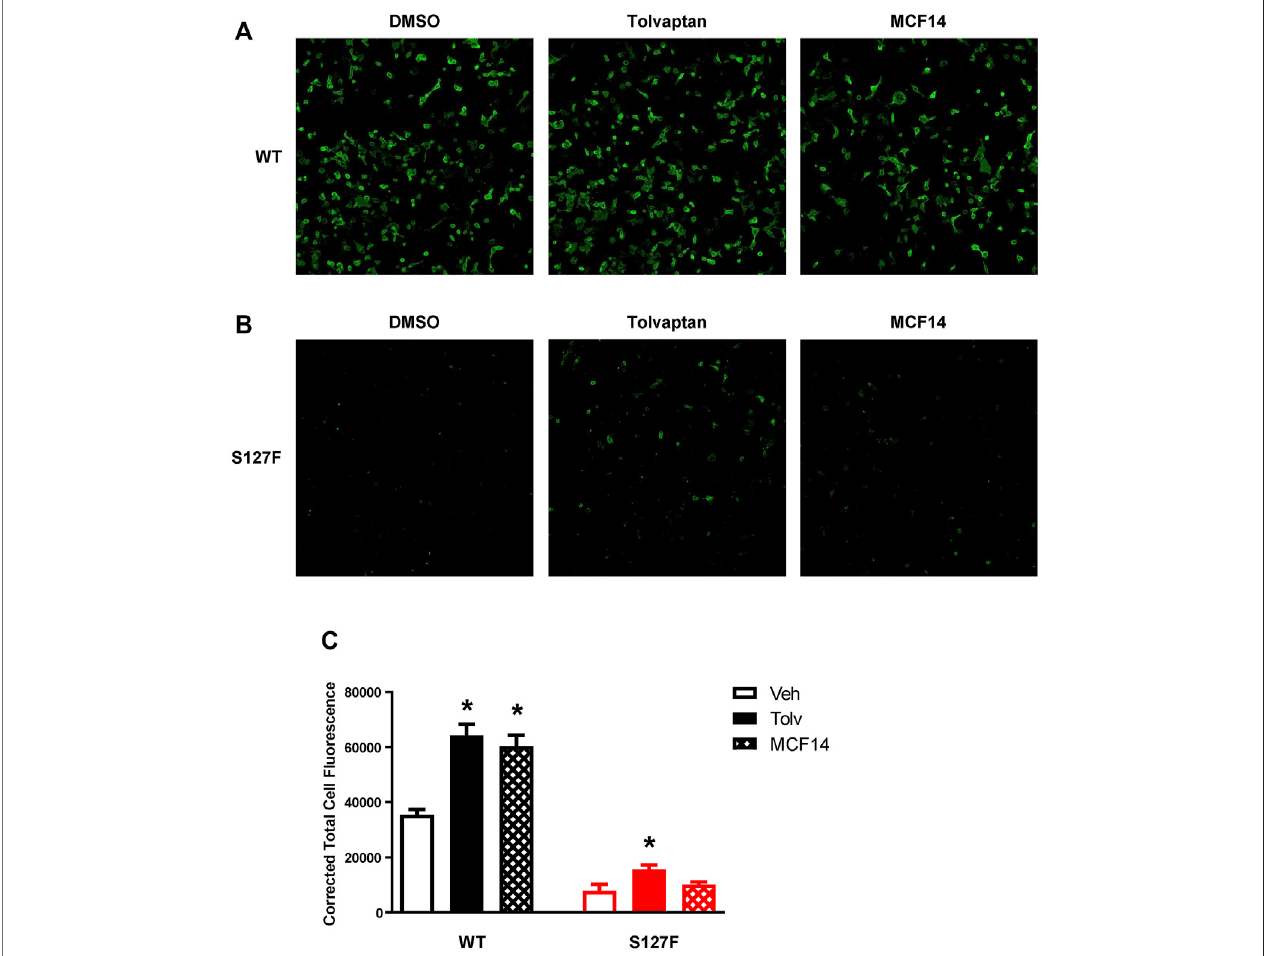
FIGURE 7 | Visualization of cell surface expression of the WT-V2R or S127F-V2R after treatment with the pharmacochaperone V2R ligands. HEK293 cells were transfectedwith (A) WT-V2R-HAor (B) S127F-V2R-HAand 24 hafterthetransfection100 nM tolvaptanor10 µM MCF14orvehicle (DMSO)wasaddedtothemedium of the cells for 18 hours. The HA-tag-containing receptor variants were directly immunostained with anti-HA-Alexa488 mouse monoclonal antibody on the cell surface (using non-permeabilized staining conditions). Imaging of cells was performed with ImageXpress Micro Confocal microscope system keeping the same exposure parameters(acquisition time and gain) betweenwells. The microscopic images were obtained by using MetaXpresssoftware. (C) The cell fl uorescence wasdetermined by the CTCF method using ImageJ software. Signi fi cance was calculated with one-way ANOVA test (* p < 0.05).